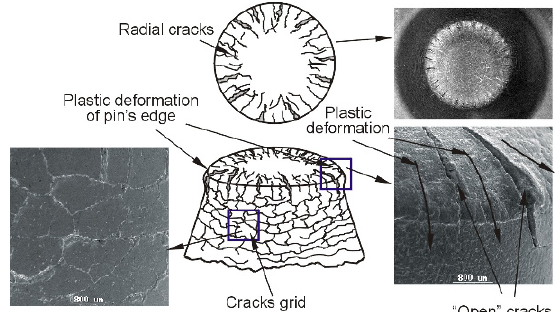
Figure 6. Observation results of the die’s pin with hybrid layer „ni- trided layer / CrN (2 µ m)” after generating 2000 pieces of forgings. shows more effective thermal protection of the substrate material than in case of the remaining dies. Compared to dies covered with 1 µ m and 2 µ m thick CrN coatings